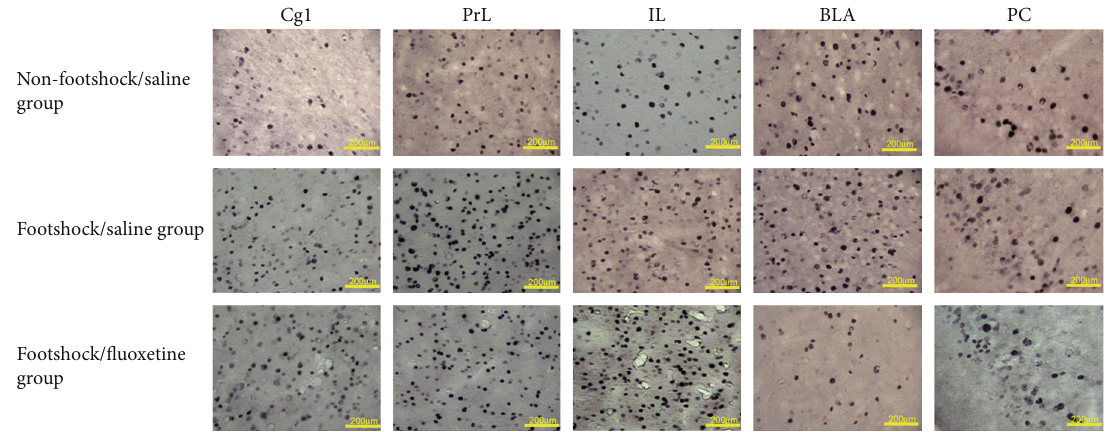
Figure 5: Representative photomicrographs of c-Fos immunoreactivity in the cingulated cortex area 1 (Cg1), prelimbic cortex (PrL), infralimbic cortex (IL), basolateral amygdala (BLA), and piriform cortex (PC) for the nonfootshock/saline, footshock/saline, and footshock/ fl uoxetine groups ( n = 5 , per